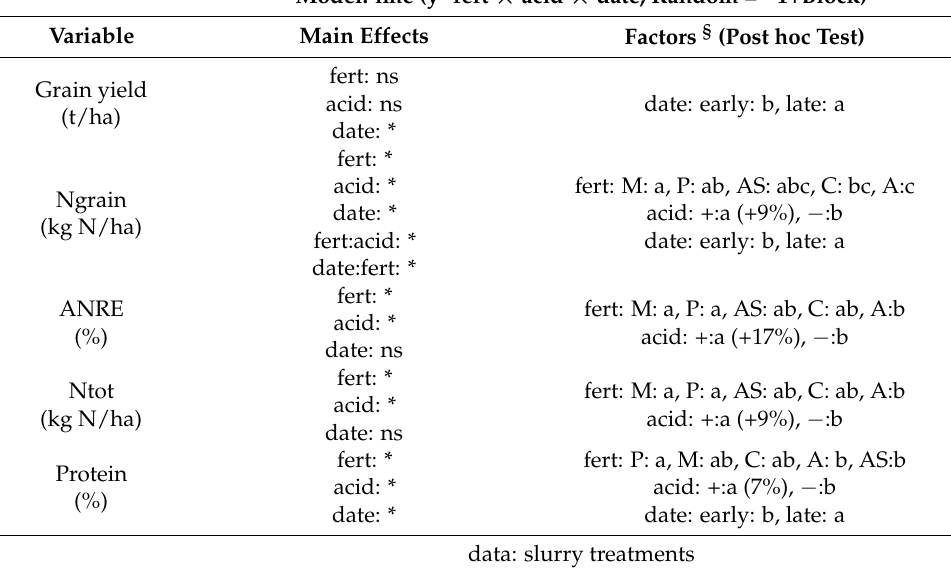
Table 5. Yield effects of 5 slurry types applied with and without acidification (sulphuric acid) to winter wheat at two different application dates. Mixed effects models with HSD post hoc test ( p < 0.05), * = significant main and interaction effects, “:” between factors indicate interaction effects, different letters indicate significance levels (values level “a” > values level